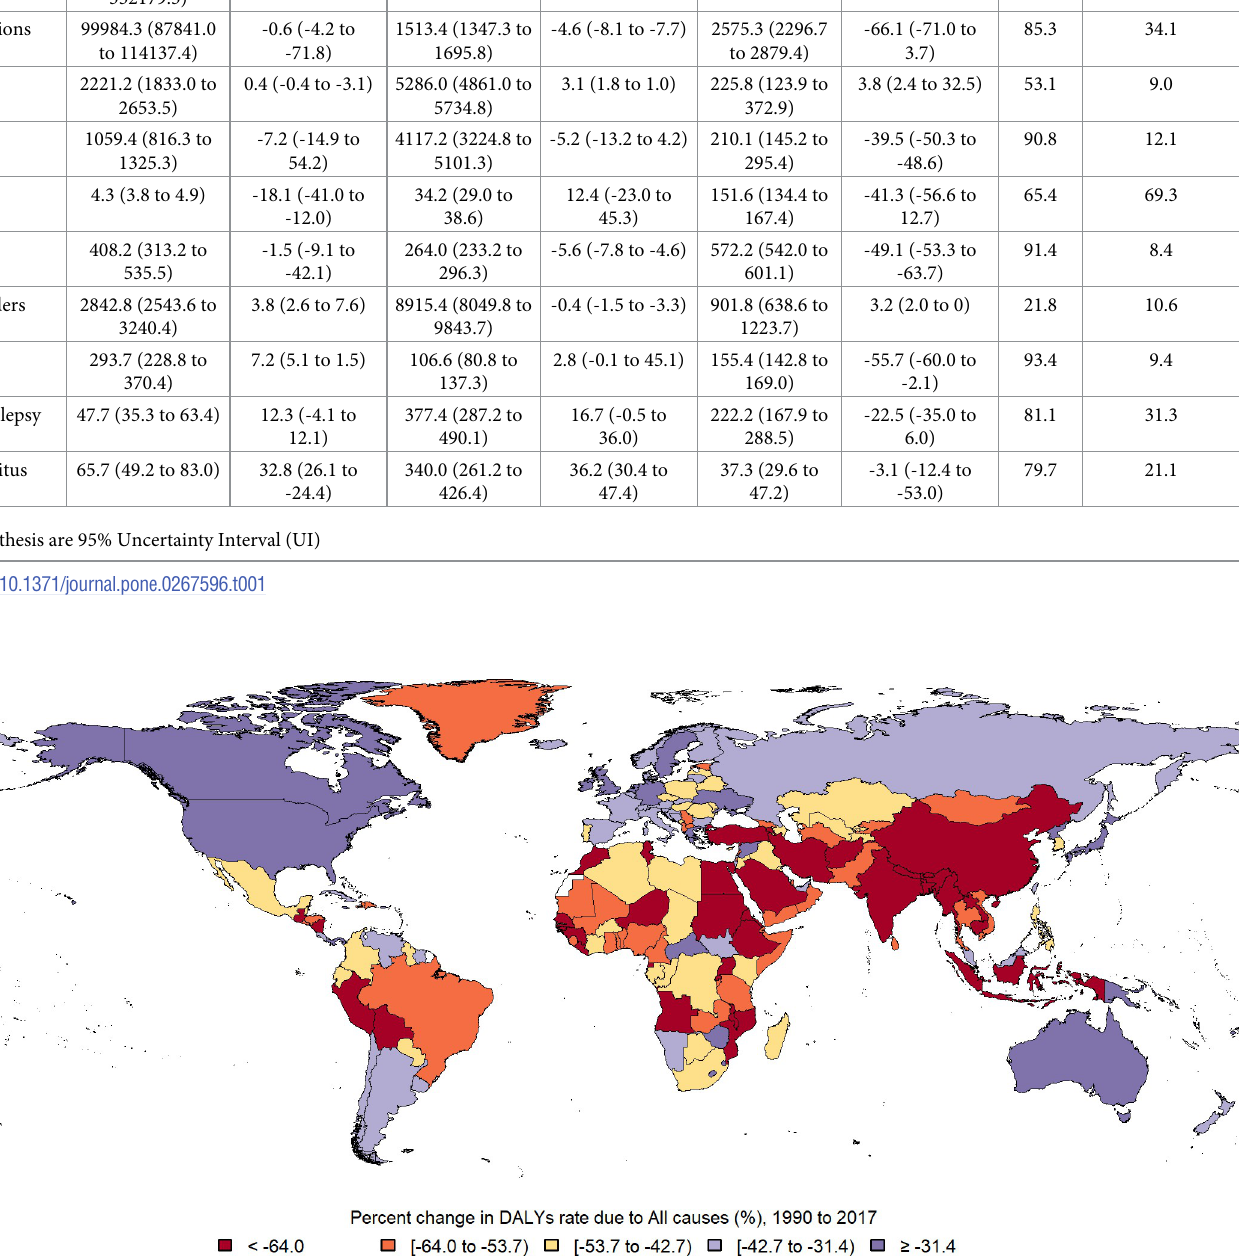
PLOS ONE | https://doi.org/10.1371/journal.pone.0267596 April 26,